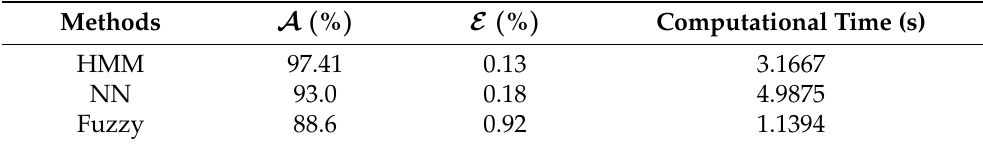
Table 4. Performance analysis of the proposed HMM, fuzzy controller and NN; w =